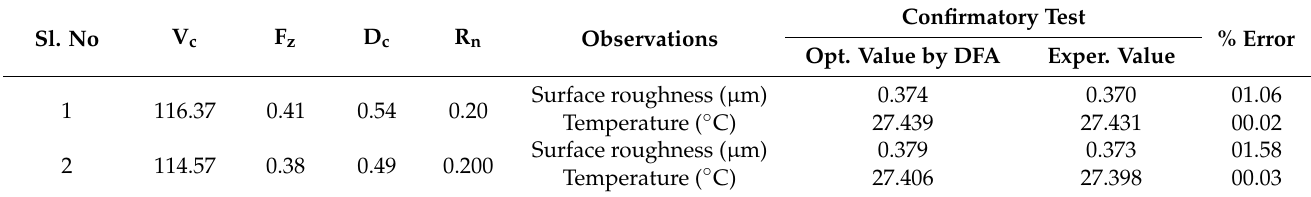
Table 9. Optimized process parameter—validation